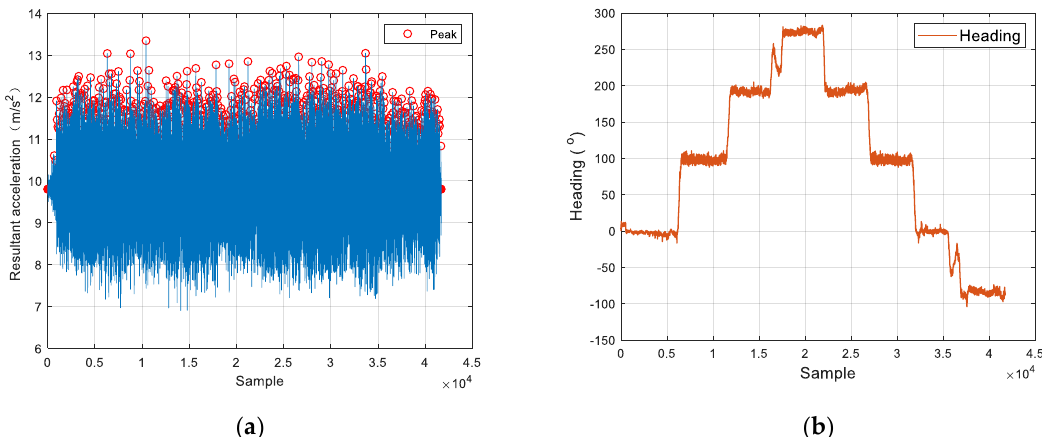
Figure 16. The PDR information in the shade experiment environment. ( a ) The results of gait detection, based on the IFSM algorithm; ( b ) the estimation of the heading angle.